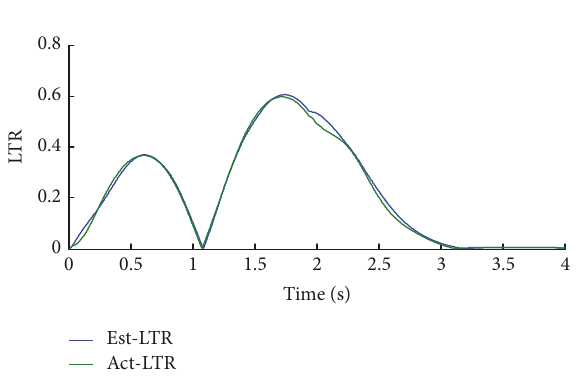
Figure 5: Estimated versus TruckSim load transfer ratio (LTR) with 89 km/h Sindwell at 90 ∘ steering amplitude.